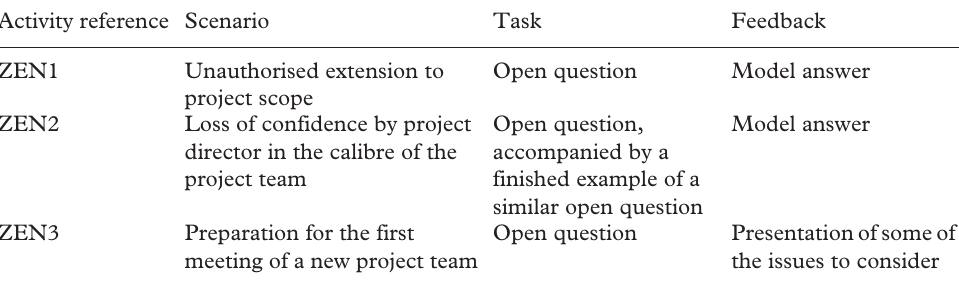
Table 1. Summary of activities used to ascertain learners’ perceptions of model answers